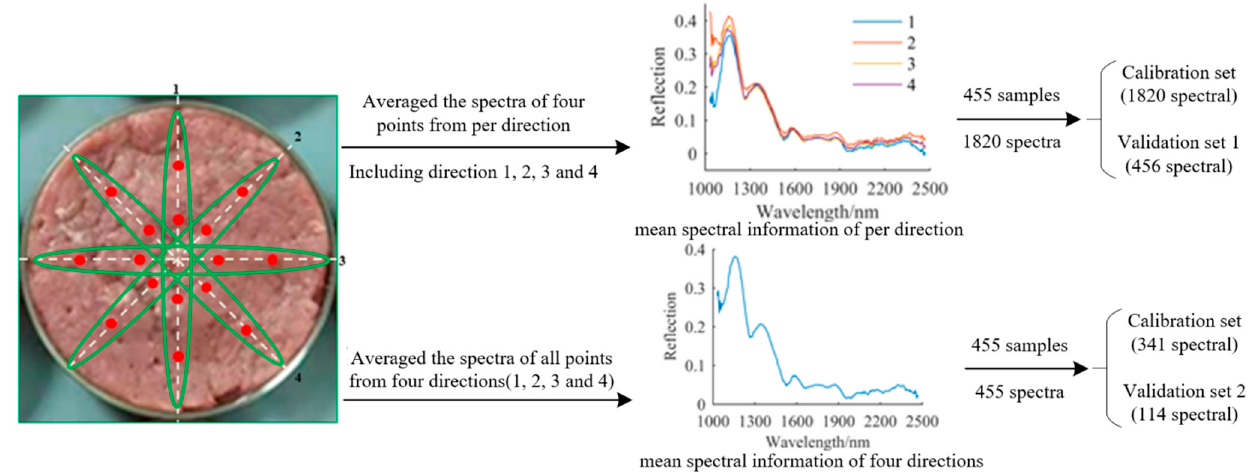
Figure 2. Acquisition process of different spectral information and dataset division.